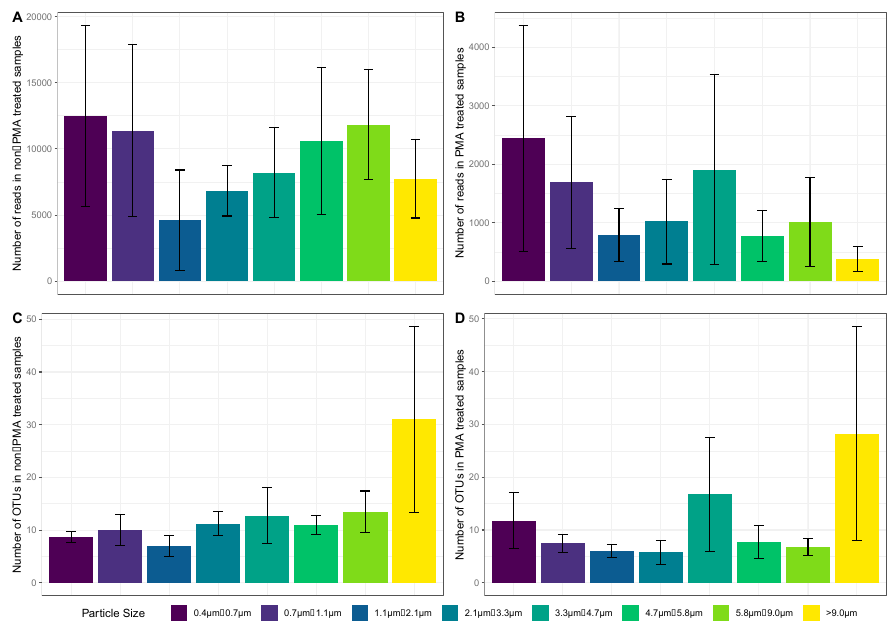
Figure 6. Bar charts showing on the y -axis, the mean number of fungal reads ( A and B ) and mean operational taxonomic units (OTU) richness ( C and D ) per stage of the ACI-8. Plots 6A and C are of the non-PMA samples (total fungal diversity), and plots 6B and D are of the PMA-treated (viable fungi). The lines within each histogram represent the standard error. The bar charts are colored based on their position within the ACI-8, representing different particle sizes.